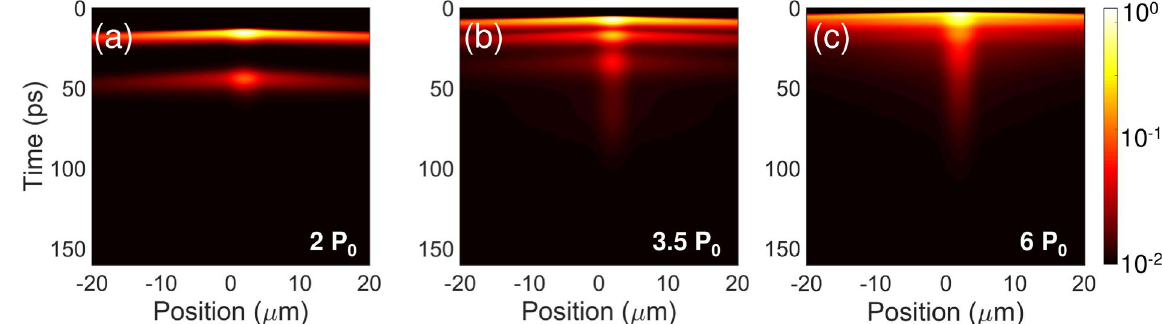
Figure 4. Simulated dynamics of a free-propagating polariton condensate. Simulation results for pumping strengths ( a ) 2 P 0 , ( b ) 3.5 P 0 , ( c ) 6 P 0 . P 0 stands for pumping amplitude to observe first condensation pulse. The condensate parameters are the same as for the disordered case. Simulation results are also convolved with a streak camera response function. The pseudo-color scale is logarithmic and the intensities are normalized to the maximal